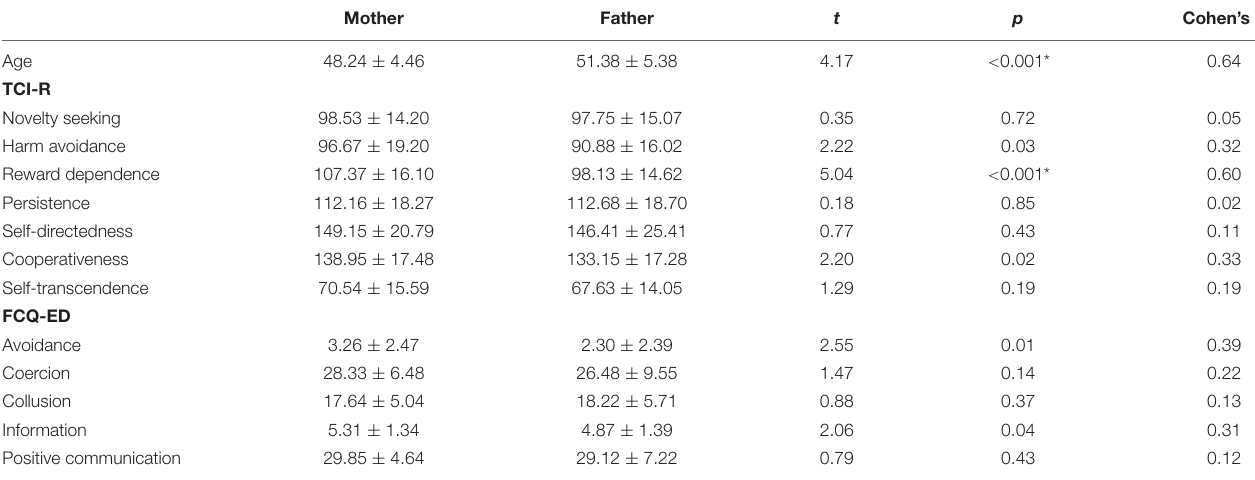
TABLE 1 | Demographic and clinical characteristics of the group of mothers and fathers.